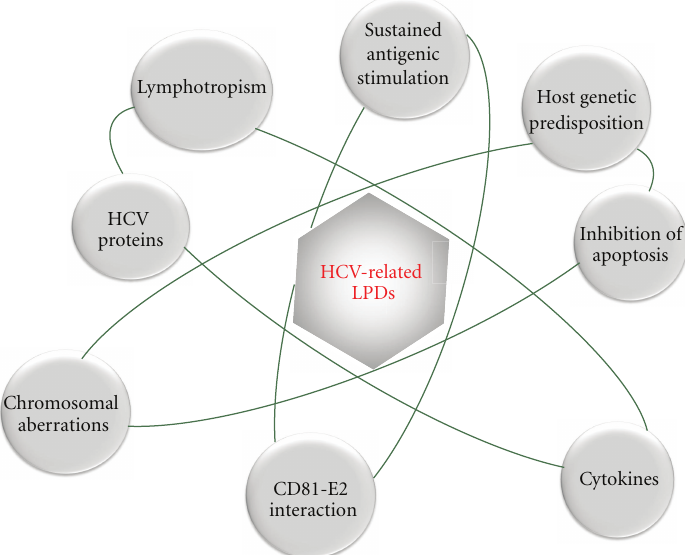
Figure 1: Pathogenesis of HCV-related lymphoproliferative disorders (LPDs). Main working hypotheses and their principal interconnec-